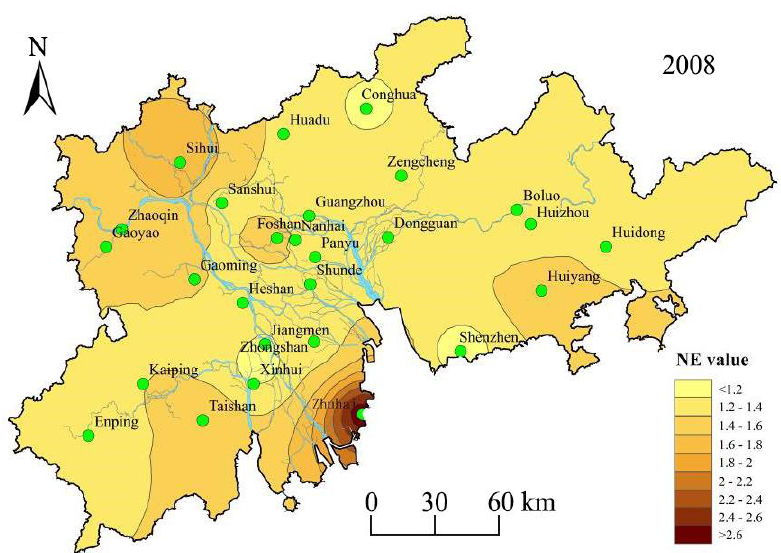
Figure 4c: The network efficiency (NE) of land-based transport network in the PRD,